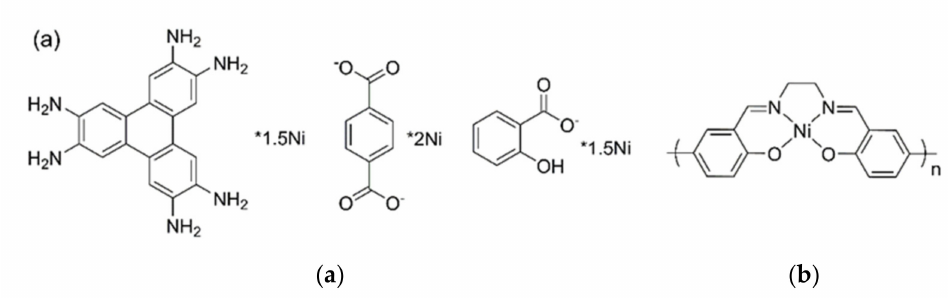
Figure 1. ( a ) Nickel metal–organic polymers (MOPs) used as electrode materials for supercapacitors; ( b ) a representation of a NiSalen